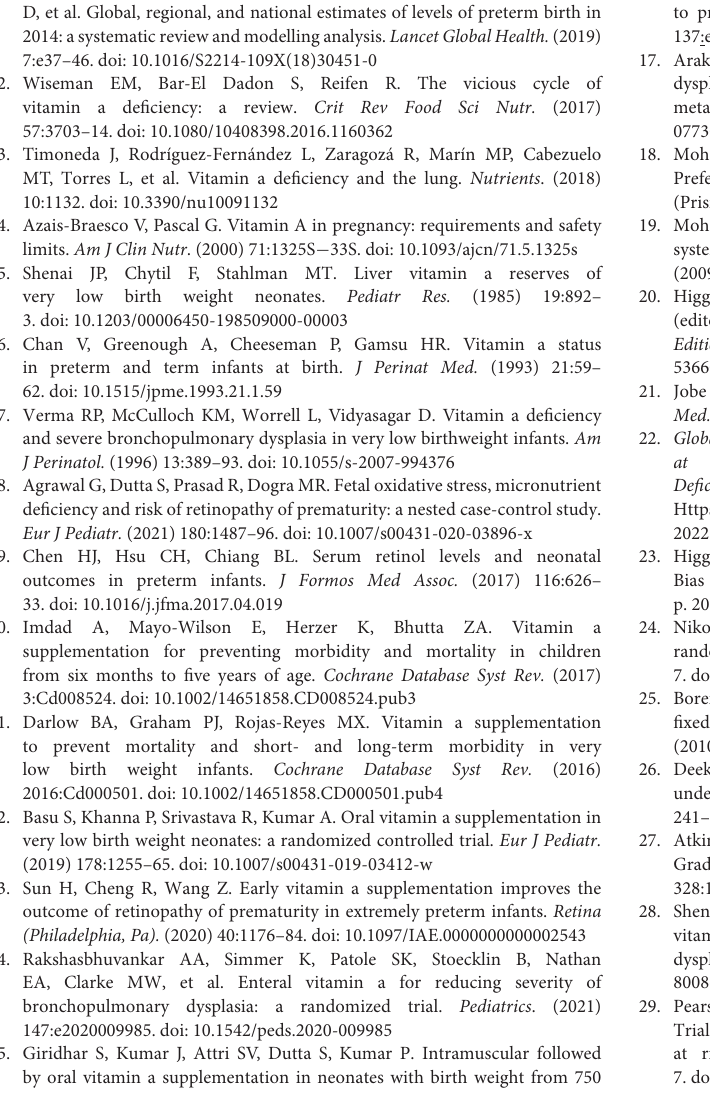
Supplementary Figure 4 | The forest plot for the incidences of IVH. (A) The forest plot for the incidence of IVH of any grade. (B) The forest plot for the incidence of IVH of grade 3 or 4. Supplementary Figure 5 | The forest plot for the incidences of PVL. (A) The forest plot for the incidence of PVL. (B) The forest plot for the incidence of IVH of grade 3 or 4 or PVL. Supplementary Figure 6 | The forest plot for the incidences of ROP. (A) The forest plot for the incidence of ROP of any grade. (B) The forest plot for the incidence of ROP requiring treatment. Supplementary Figure 7 | (A) The forest plot for the incidence of NEC. (B) The forest plot for the incidence of sepsis. Supplementary 1 | Search